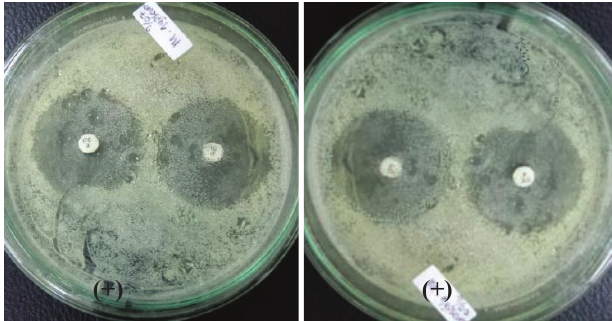
Figure 2. Positive control’s Antifungal activity test on Microsporum gypseum sample results in positive result (Table